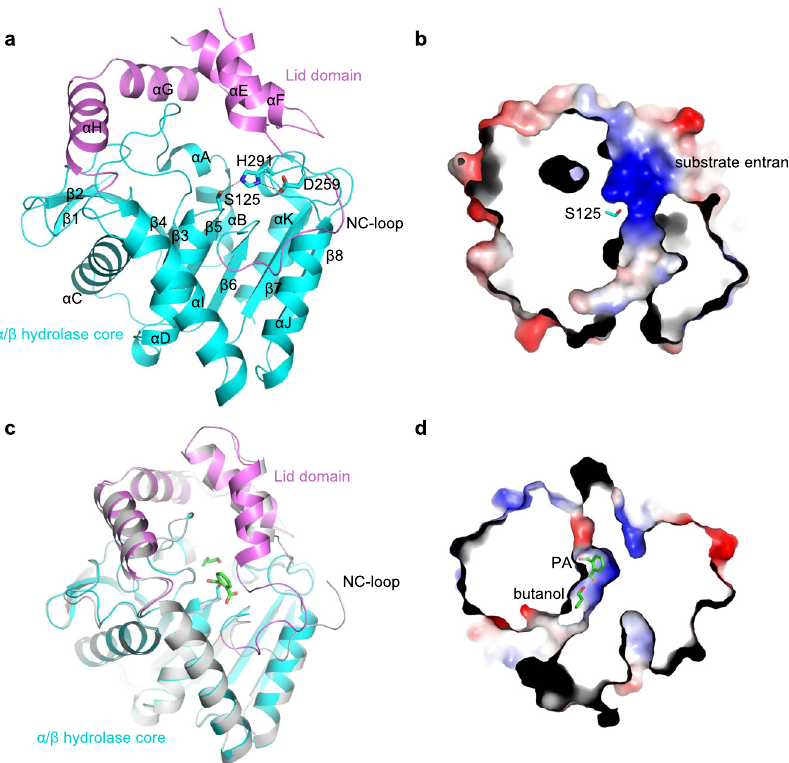
Fig. 2 Structure of MehpH in apo and in complex with ligand. a Crystal structure of MehpH in apo form. The lid domain and α / β hydrolase core are colored in purple and cyan, respectively. Similar colors are used in other panels unless otherwise indicated. The catalytic triad (Ser125, Asp259 and His291) is shown in stick representation. The α -helices and β -strands are labeled from A to K and from 1 to 8, respectively. b The penetrating tunnel in the structure of apo-MehpH. c Structure superposition of apo-MehpH and MehpH-ligand complex, in which apo-MehpH is colored in grey. The Ser125-PA covalent intermediate and butanol are shown as sticks. d The location of Ser125-PA covalent intermediate and butanol in the penetrating tunnel of MehpH-ligand